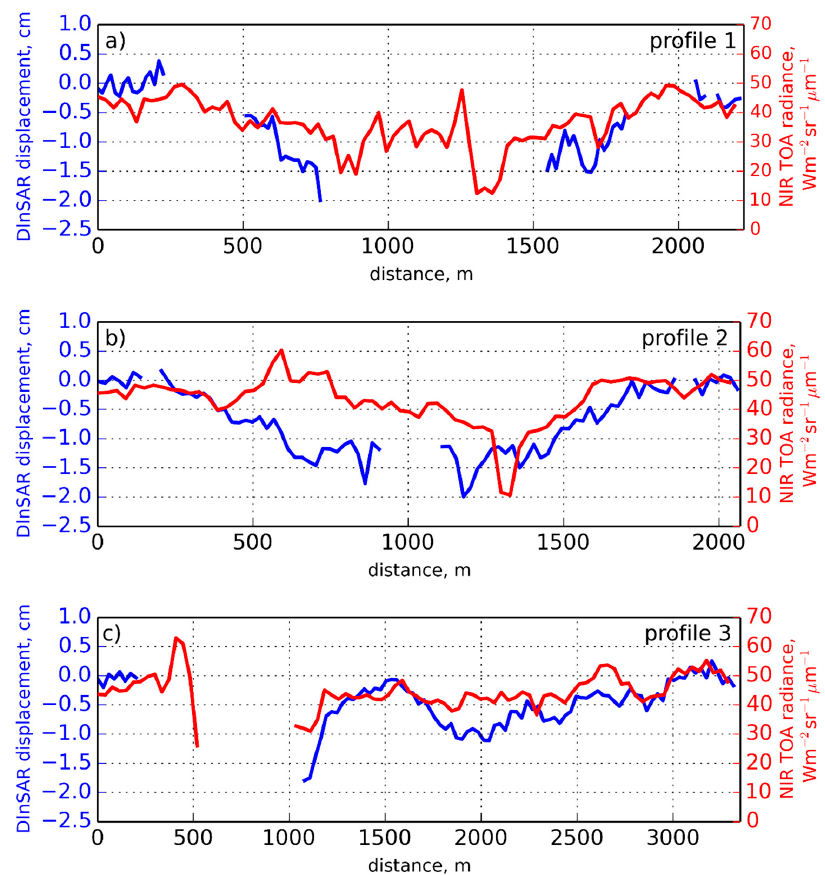
Figure 9. Profiles across three selected thermokarst basins: ( a ) profile 1 in Figure 8B; ( b ) profile 2 in Figure 8C; ( c ) profile 3 in Figure 8D.